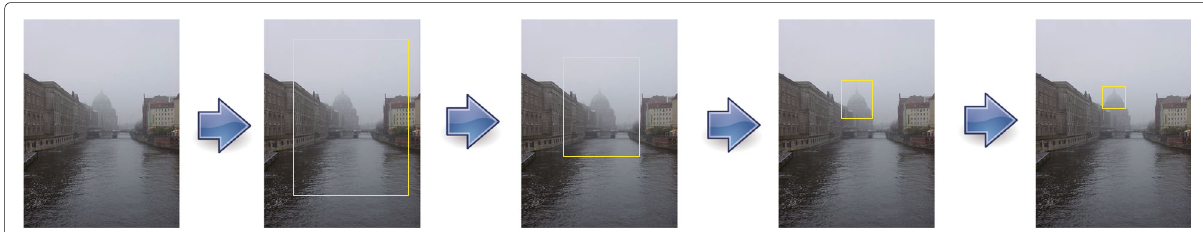
Fig. 3 The RNN module detects the farthest target from the image